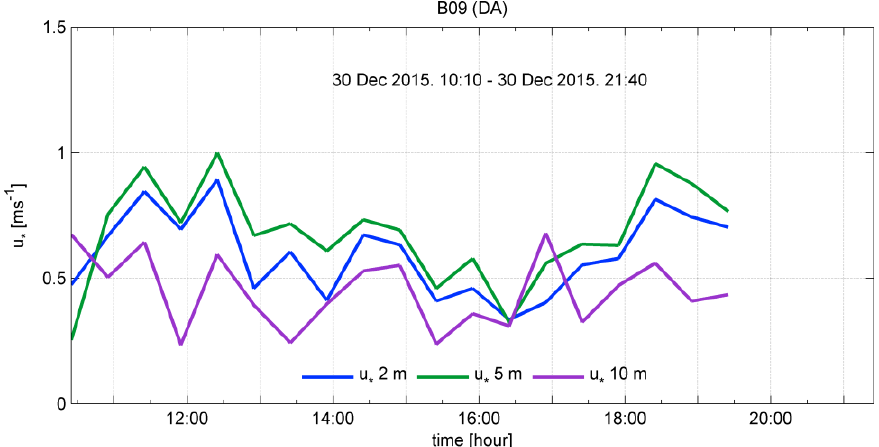
Figure 14. As with Figure 13, but for the bora episode B09 (DA).